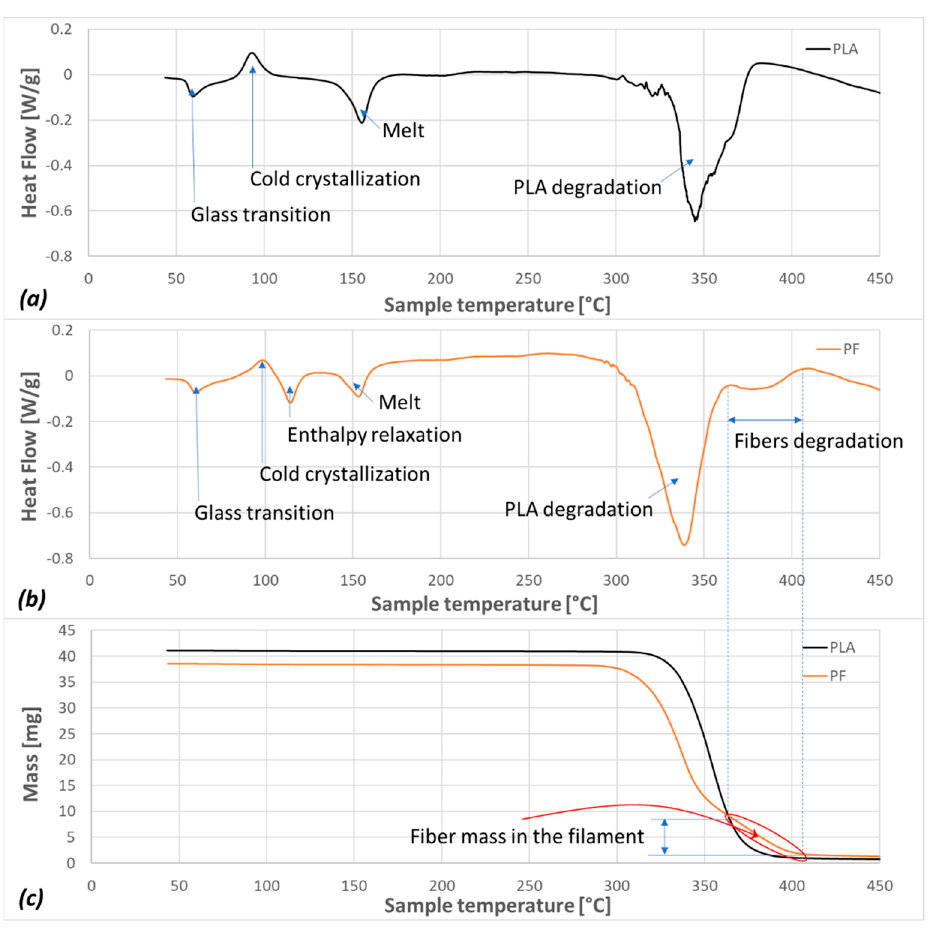
Figure 5. Heat flow (HF) of as-received PLA ( a ), PF ( b ), and mass loss ( c ) of PLA and PF filaments during DSC/TGA tests.